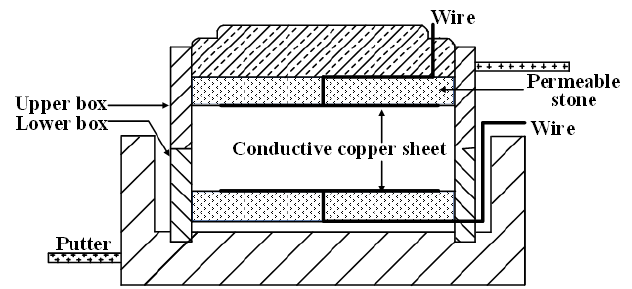
Figure 6. Schematic diagram of new direct shear box.